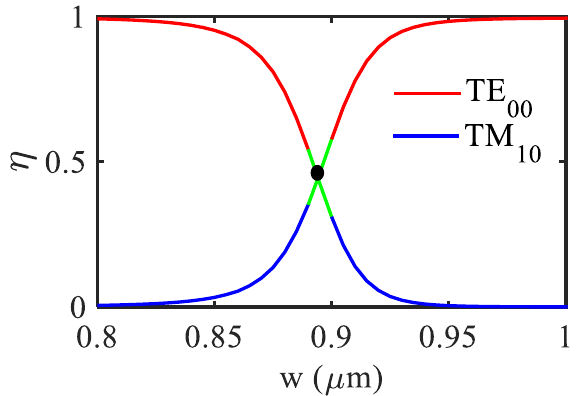
Figure 4. Variation of mode hybridization factor with waveguide’s width for HI-MCRW. It has been noticed that around the hybridized point, the modal loss associated with the TE 00 mode is quite high, which affects the peak reflectivity of the proposed sensor. In order to show this, in Figure 5a we have plotted the propagation length L p as a function of the HI-MCRW’s width ( w ) for both the modes and in Figure 5b–d, respectively, the reflected spectrum for three different widths corresponding to points A, B, and C as highlighted in Figure 5a. The dotted horizontal line in Figure 5a represents the grating length 0.8 mm. At point B (hybridized point), since the propagation length of the mode is much lower than the grating length, the peak reflectivity is extremely small (< 0.05), making it difficult to detect. At points A and C, the peak reflectivity is significantly higher as the propagation length of the mode equal to the grating length. A similar kind of behavior also observed with the ambient RIs. In view of the above, from a practical point of view, in our analysis we have neglected the region around the hybridized point where the propagation length is lower than the grating length. Therefore, the range of discontinuity in Figure 3 represents the region in which the propagation length of the TE 00 mode is lower than the grating